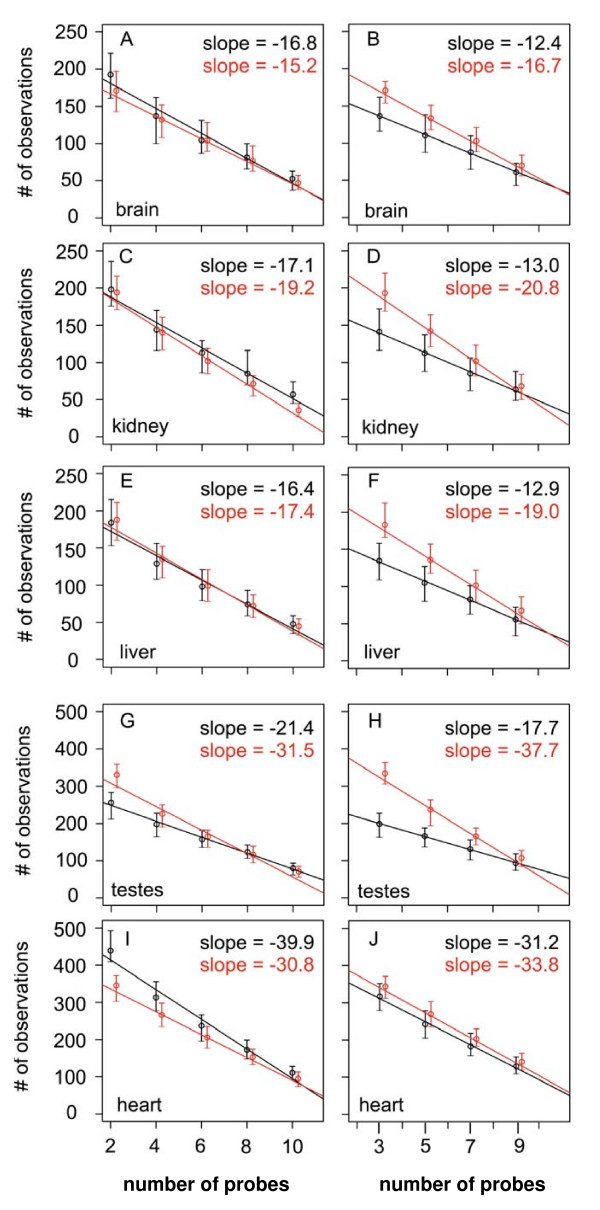
Effects of probe number on the inferences of differential gene expression. The median number of gained (black) and lost (red) inferences of differential gene expression (Y-axes) in simulated data sets subjected to random probe masking relative to actual data are plotted against the number of probes in a probe set (X-axes) (see text for details). Error bars represent the observed range of inferred differential gene expression in the simulated data sets. Red and black data points are slightly off-set for visual clarity. Data from probe sets with even (Panels A, C, E, G, and I) and odd numbers of remaining probes (Panels B, D, F, H, and J) are presented separately, as described in Figure 3. The tissue from which the data was collected is indicated in the lower left hand corner of each panel. Note the different scales on the y-axes for heart and testes.